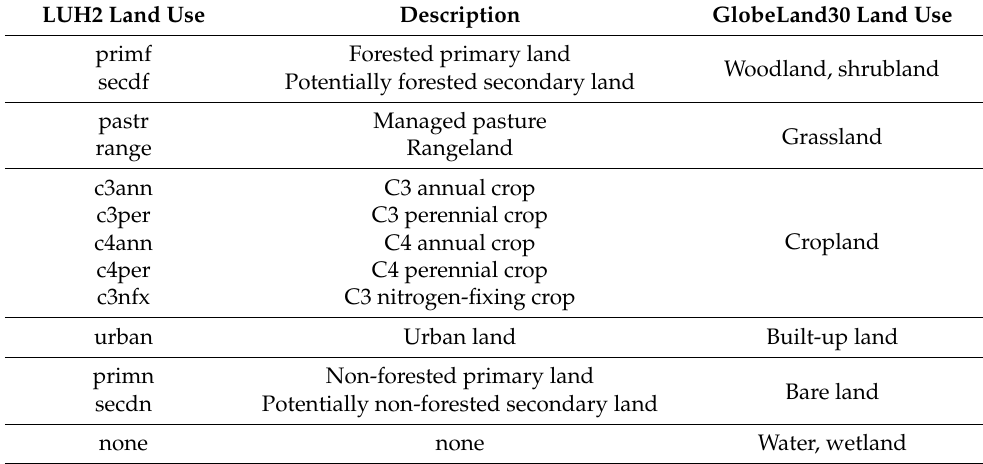
Table 3. The reclassification of land use types in LUH2.